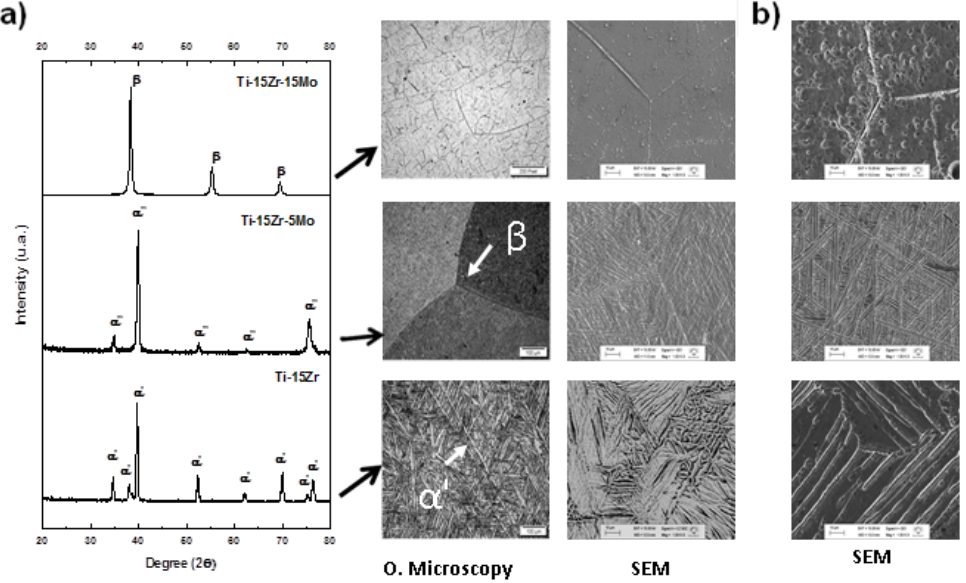
Figure 1: XRD patterns, OM and SEM images of Ti-15Zr-xMo samples in the a) as-cast and b) heat-treated